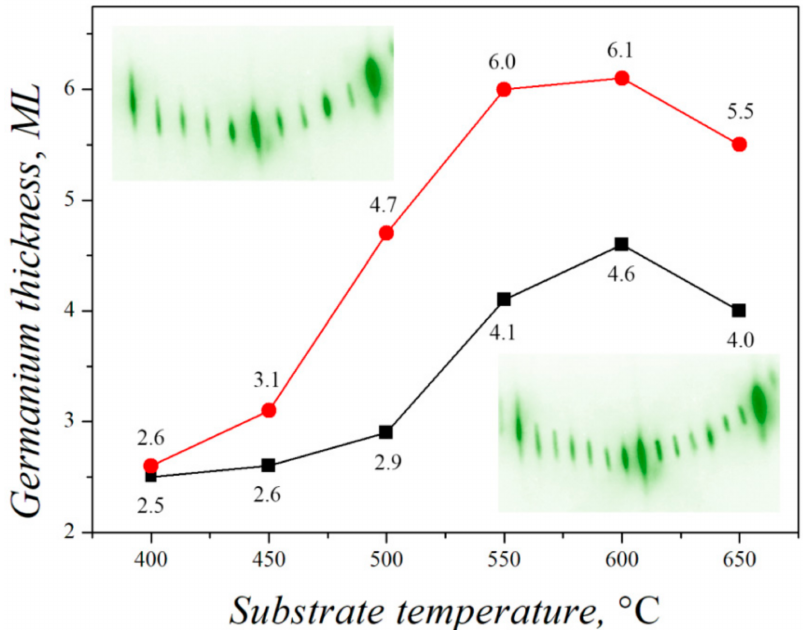
Figure 9. Temperature dependence of the thickness of germanium layer on Si(111) in the moment of transition from the 7 × 7 to 5 × 5 superstructure. Black line: the moment of appearance of the 5 × 5 superstructure. Red line: the moment of disappearance of the 7 × 7